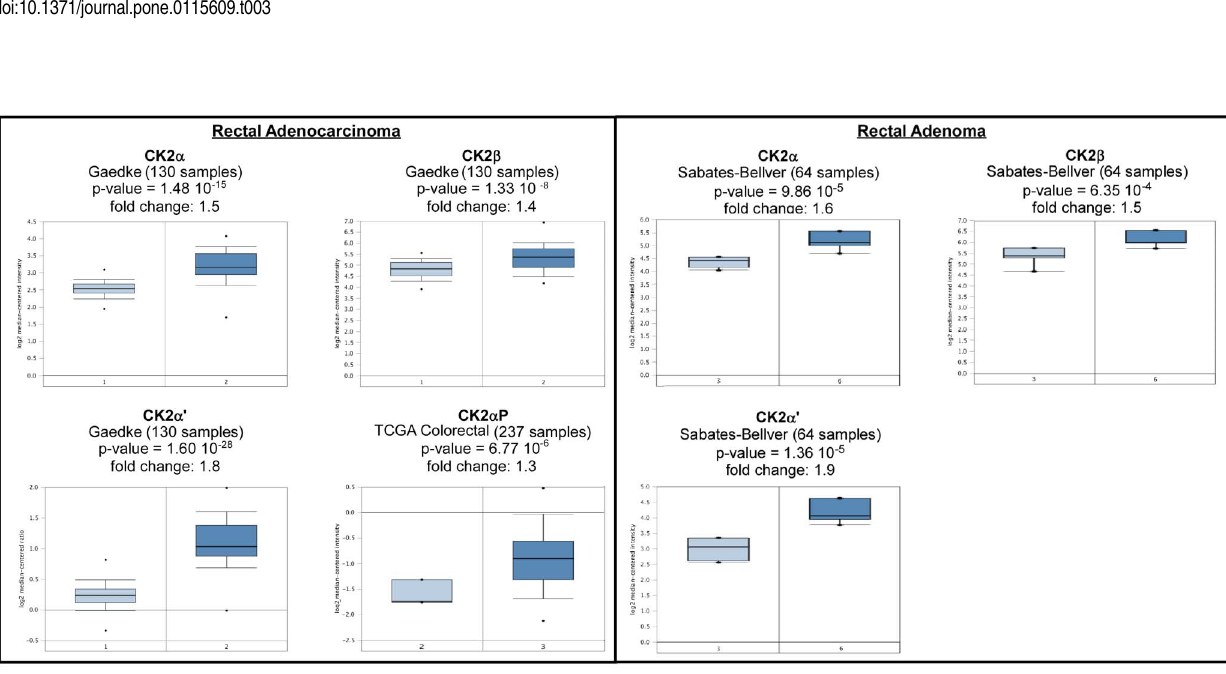
Fig. 6. CK2 gene analysis in colorectal cancer (Oncomine database). Box plots derived from gene expression data in Oncomine comparing expression of specific CK2 genes in in normal plot (left plot) and in colorectal cancer tissue (right plot). Oncomine box plots were retrieved from rectal adenomas and